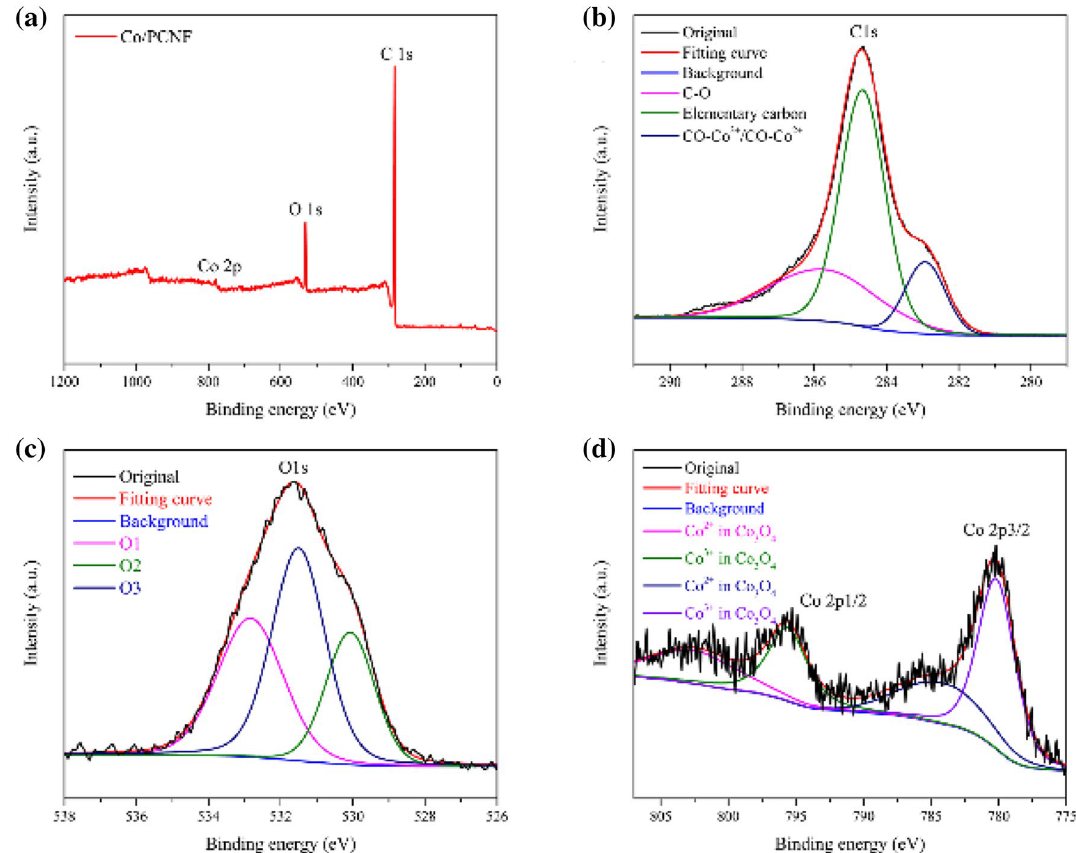
Figure 6. Raw scan XPS spectra ( a ) of Co/PCNF. XPS survey spectrum and deconvolution of Co/PCNF (S1) ( b ) C 1s, ( c ) O 1s, ( d ) Co